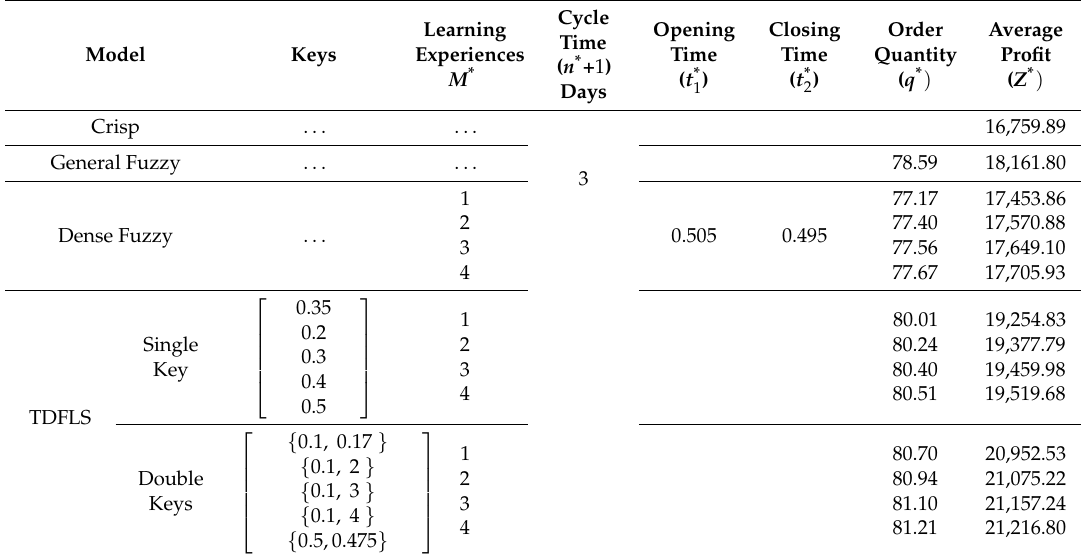
Table 3. Optimum solution for Model